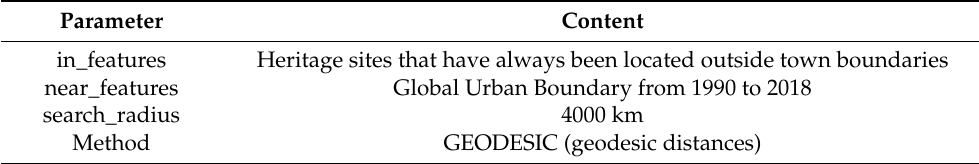
Table 3. Input data form for the near